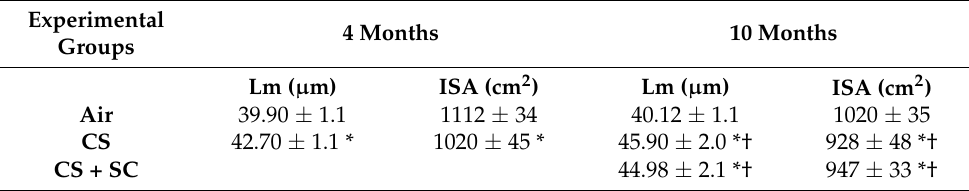
Table 1. Lung Morphometry of C56Bl/6J Mice from the Different Experimental Groups. Experimental